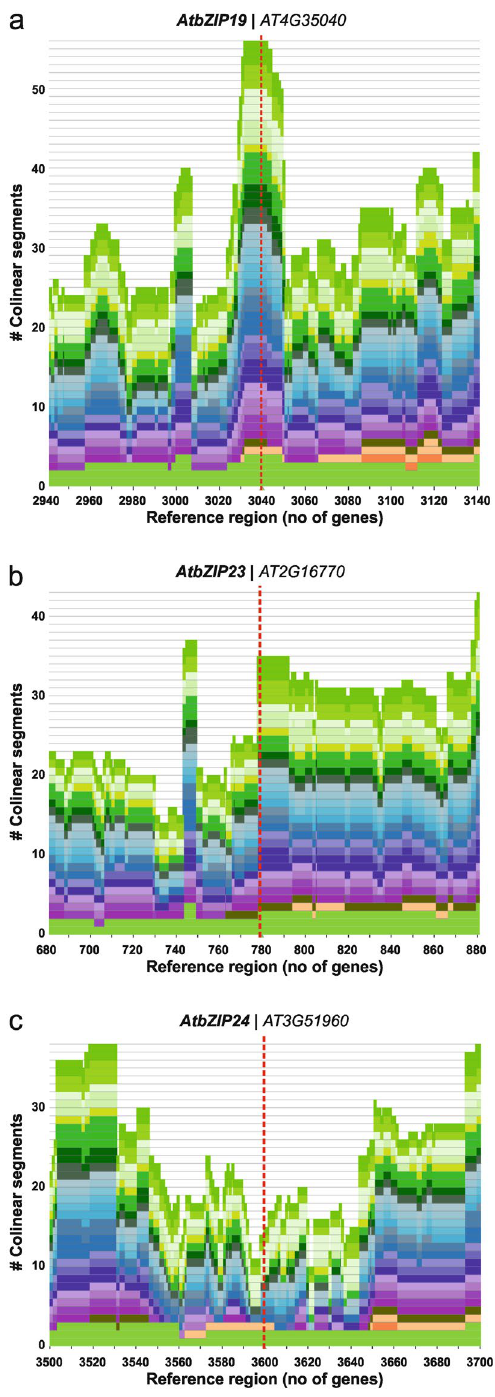
Figure 3. Collinearity analysis for A. thaliana F-bZIPs’ genomic regions in comparison to other plants species. Skyline plots were produced with PLAZA, using the AGI codes for AtbZIP19 ( a ), AtbZIP23 ( b ) and AtbZIP24 ( c ) as queries. The red dashed line localizes the position of the F-bZIP gene in the genome